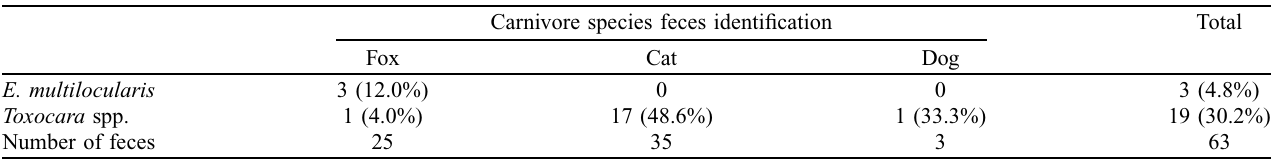
Table 2. E. multilocularis and Toxocara spp. infection level of feces collected in kitchen gardens depending on the carnivore species